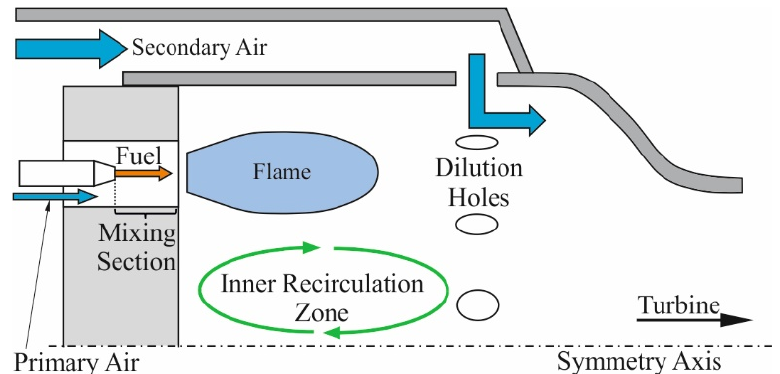
Figure 3. Schematic of jet-stabilized combustion principle in MGT configurations.